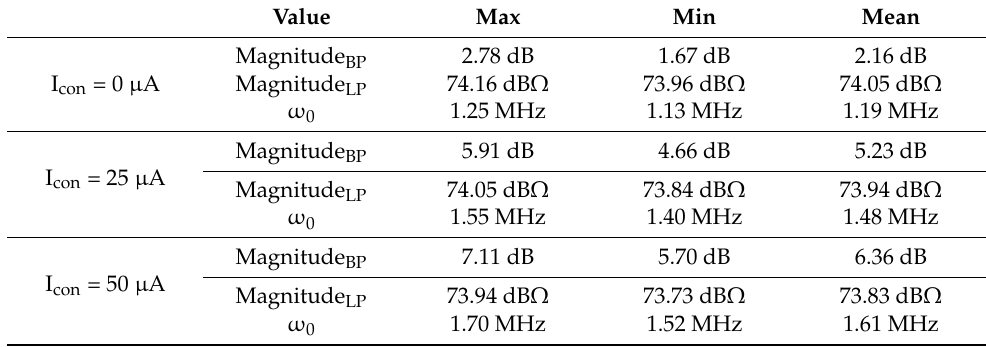
Table 2. PVT and Monte Carlo simulation results for the magnitude of the filters and their ω 0 .